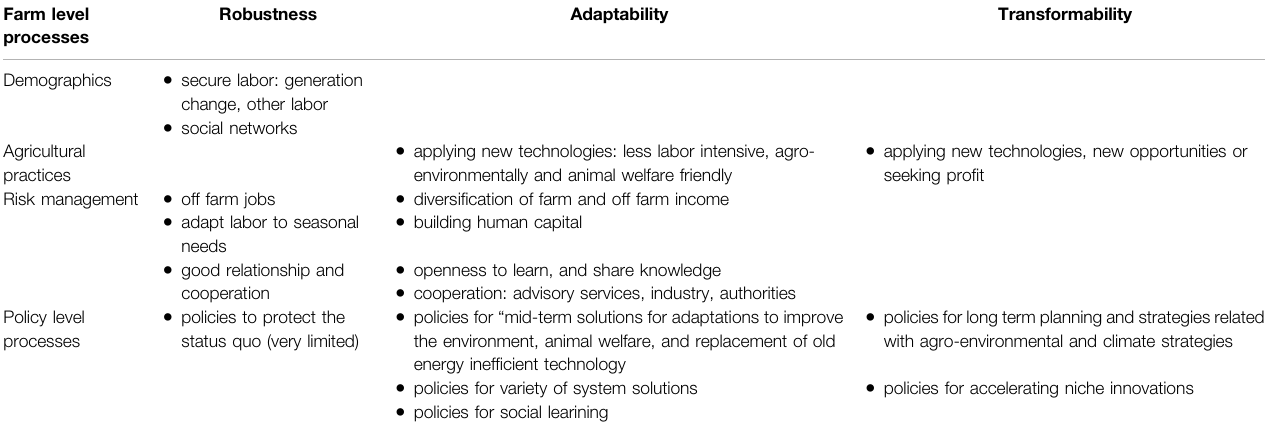
TABLE 2 | Summary of farm level and policy level attributes enhancing the resilience capacity: robustness, adaptability, and transformability. Farm level